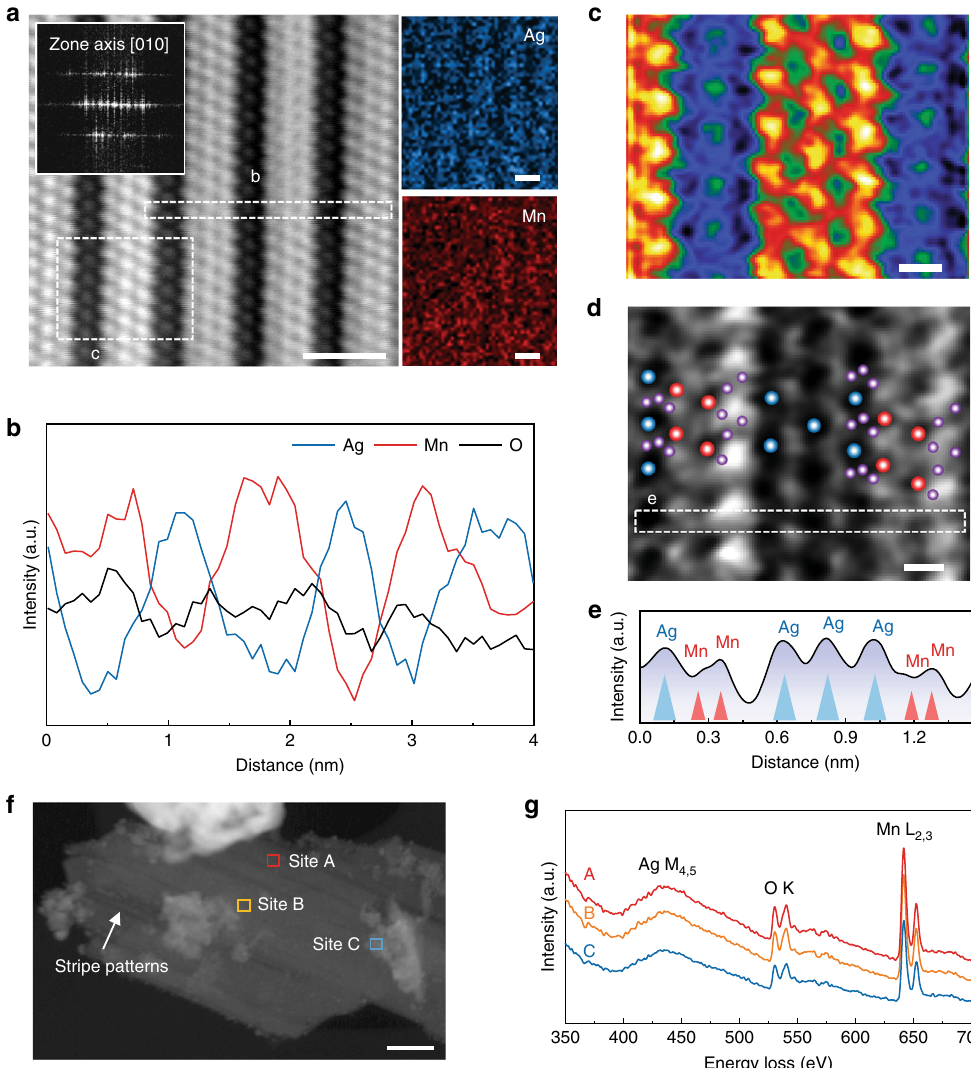
Fig. 2 Atomically resolved electron microscopy and electron energy loss spectra. a Filtered high-angle annular dark- fi eld-scanning transmission electron microscopy (HAADF-STEM) and energy-dispersive X-ray spectroscopy (EDX) mapping image of the silver manganate nanoplate (SMNp) along the [010] zone axis with its fast Fourier transform (FFT) pattern, showing continuous arrangements of silver and manganese atoms. b Line-scanning pro fi le showing distinct distributions of silver and manganese elements. c , d Simulated HAADF-STEM image ( c ), indicating the highest electron density with red color and the lowest with black, and annular bright- fi eld (ABF) – STEM image ( d ) showing the Ag 2 MnO 4 orthorhombic structure with silver (blue), manganese (red), and oxygen (purple) elements. e Corresponding ABF intensity pro fi les of the white box in d present the peaks of the silver and manganese atomic columns. f , g A HAADF-STEM image ( f ) and the corresponding electron energy loss spectroscopy (EELS) pro fi les ( g ) at the marked sites, showing Ag M 4,5 -edge, O K-edge, and Mn L 2,3 -edge. Scale bars, 1 nm ( a ), 0.2 nm ( c , d ), and 50 nm ( f